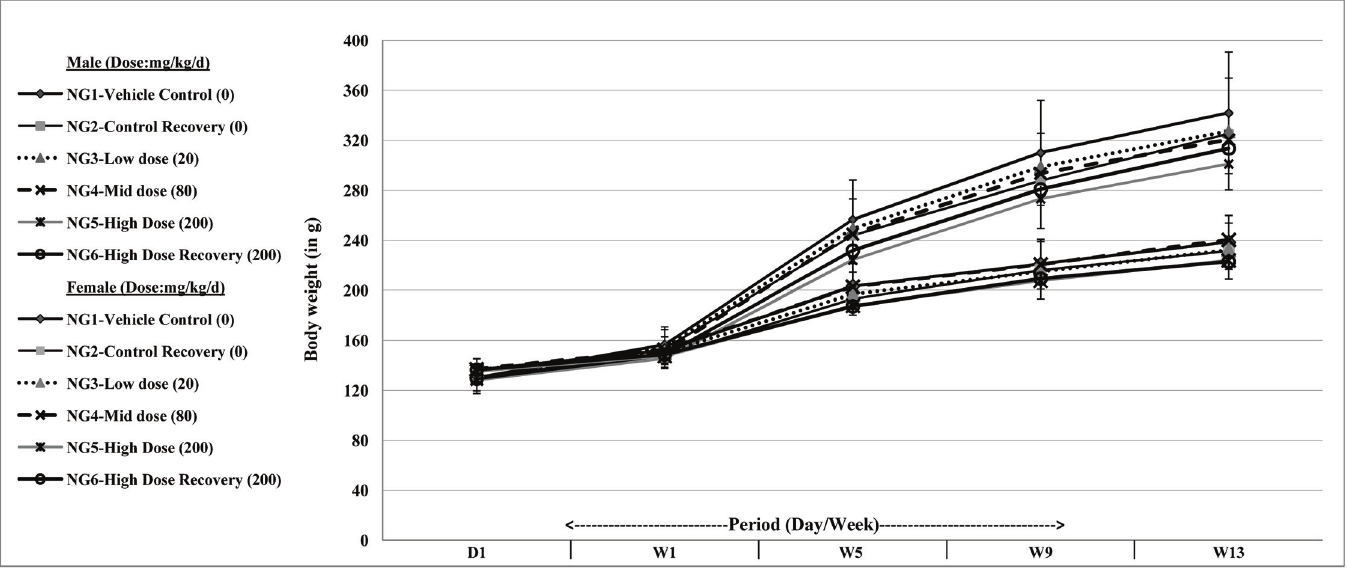
Fig 2. Body weight changes on oral administration of 3’-HPT measuredover 13 weeks (90 days) in male and female SD rats. D1: Day one; W1, W5, W9 and W13: Week one, five, nine and thirteen. Data in Mean ± SD (n =